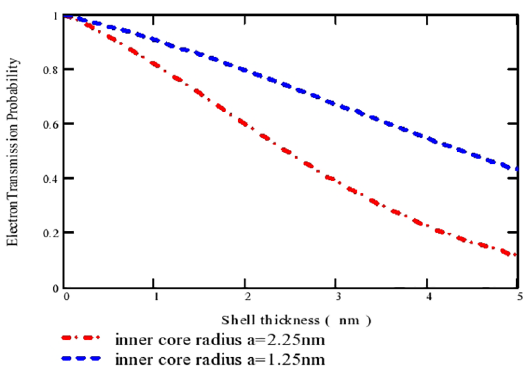
Figure 2. Variation of electron transmission probability as a function of shell thickness in ZnSe/ZnS Core shell quantum dot